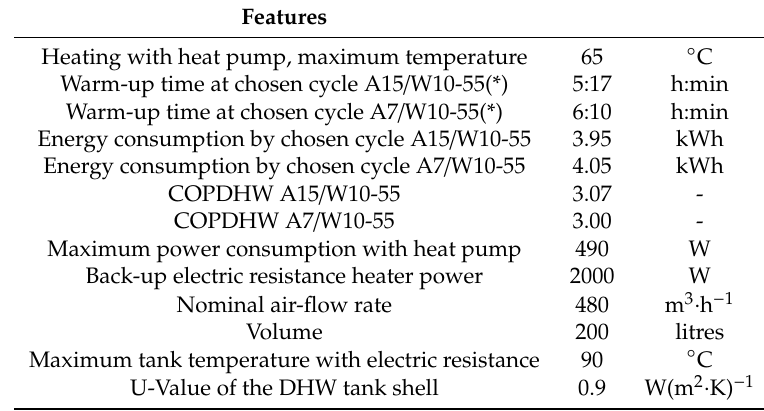
Table 1. Heat pump water heater (HPWH) features from technical datasheet. DHW—domestic hot